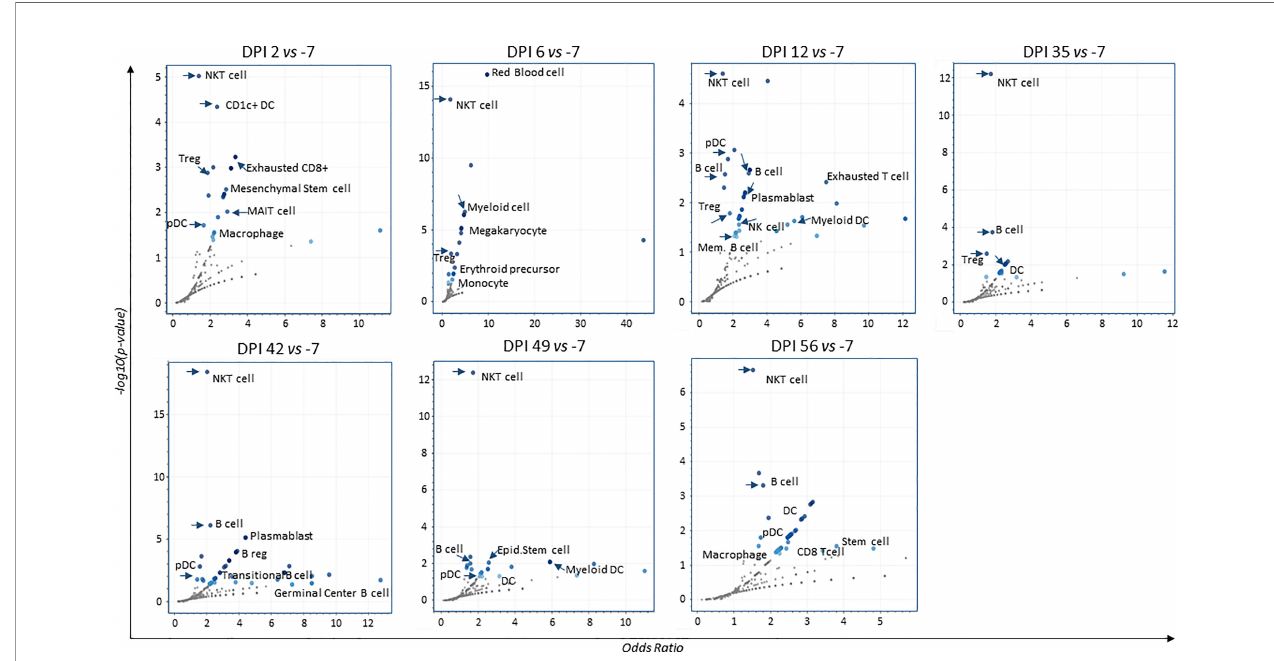
FIGURE 5 | Volcano plots for augmented cell-populations following infection. RNA-sequencing of whole blood cell-populations at each time-point compared to baseline (DPI − 7) (analyses using Enrichr/CellMarkerAugmented2021 and Appyter applications). Each volcano plot shows the signi fi cance of each gene-set (dark blue dots). x-Axis measures the odds ratio (0, inf) calculated for the gene-set, while the y-axis gives the – log10( p -value) of the gene set. Larger blue points represent signi fi cant terms ( p -value < 0.05); smaller gray points represent non-signi fi cant terms. The darker the blue color of a point, the more signi fi cant it is.